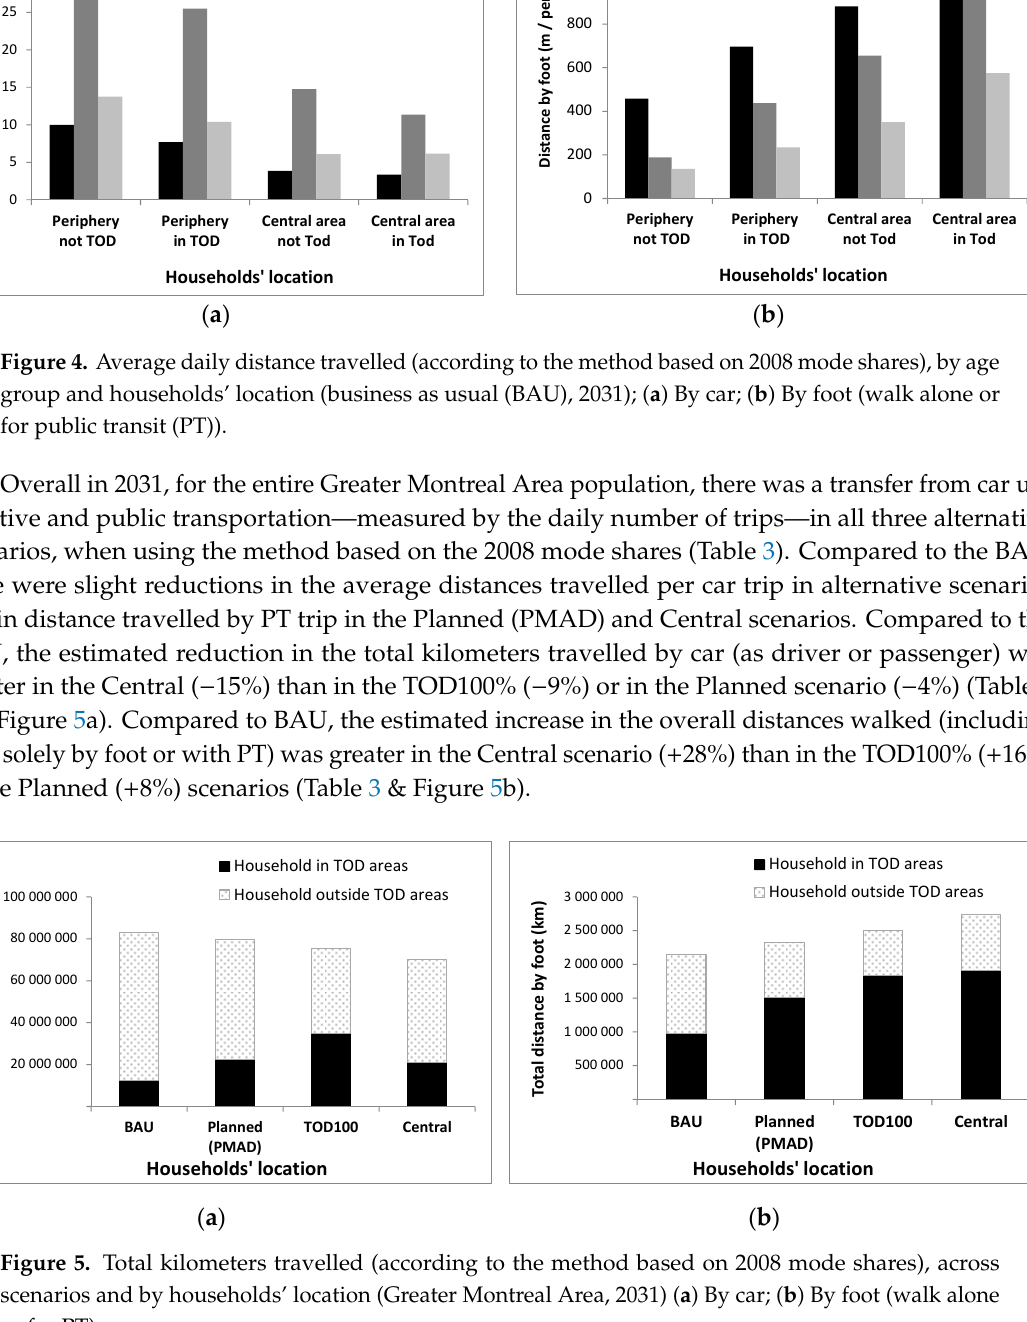
Figure 3. Population distribution, according to 2031 scenarios; ( a ) Population living in TOD areas; ( b ) Population living in the central zone.